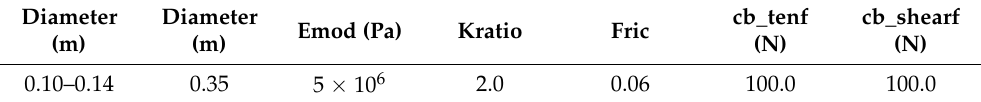
Figure 7. Triaxial compression test of soil in PFC3D. ( a ) Sample. ( b ) The calculation procedure. ( c ) Deviator stress curves. ( d ) Mohr circles and envelope line. Table 4. Micro ‐ parameters of soil.